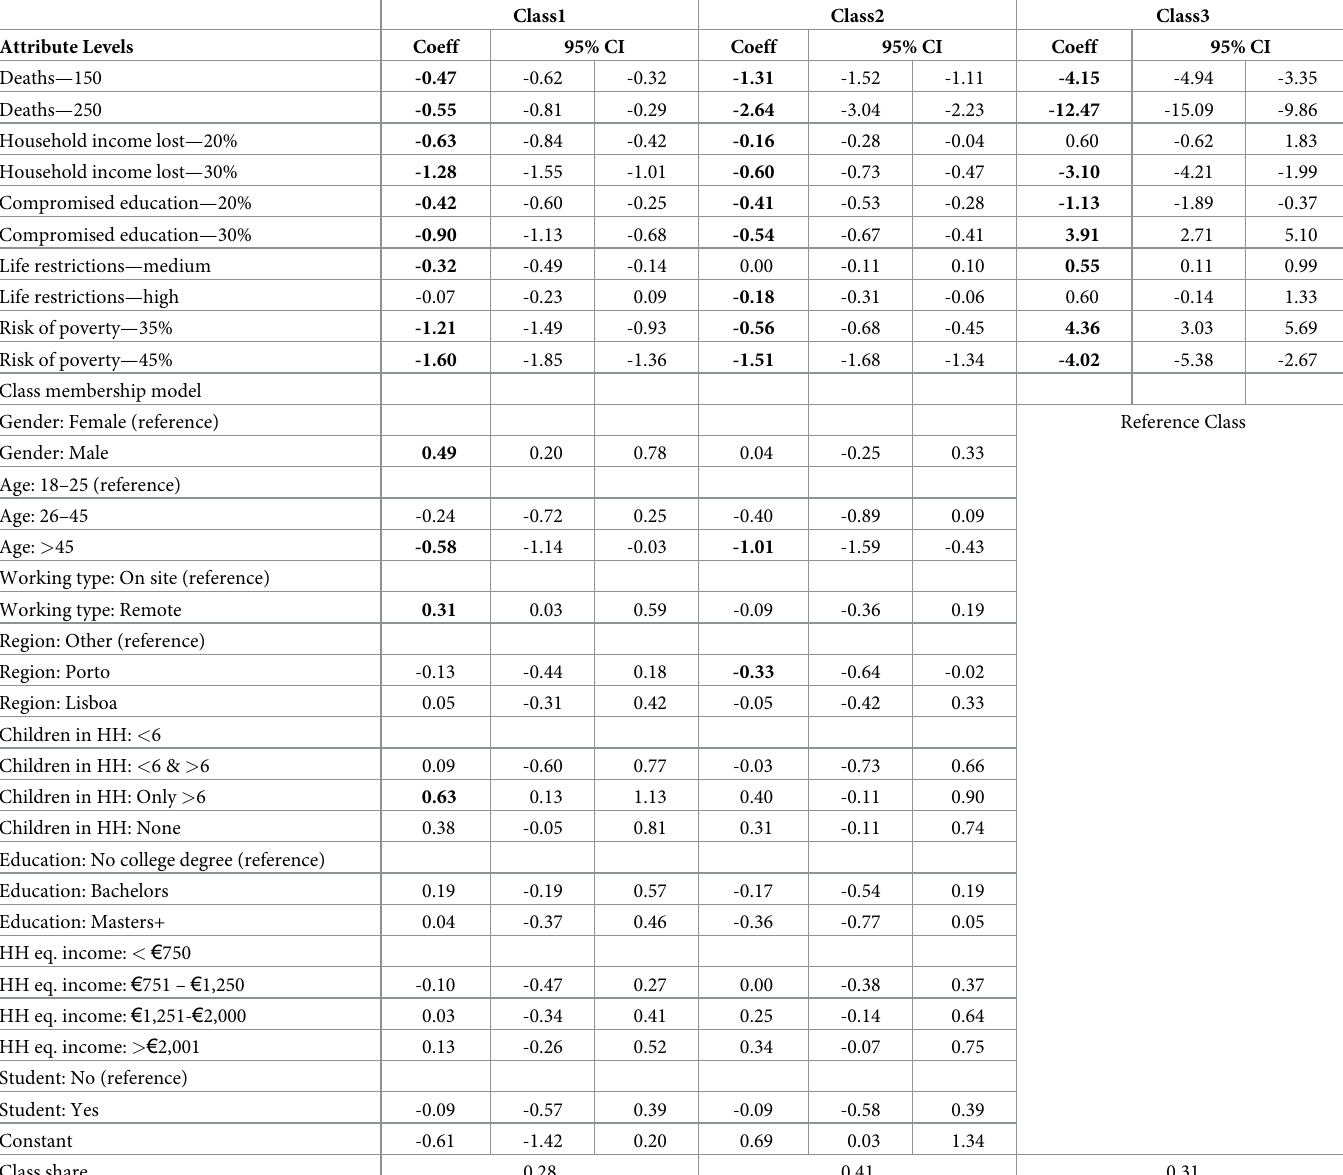
Table 4. Coefficients from the latent class model with 3